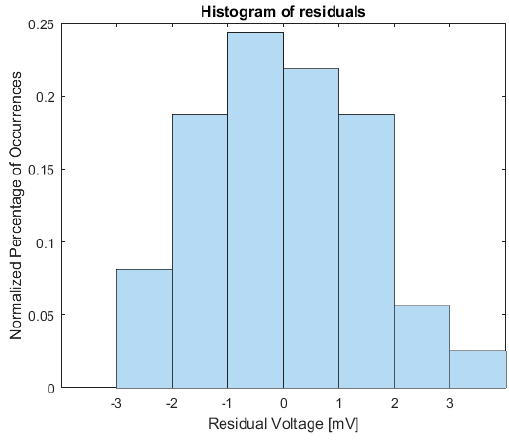
Figure 8. Residuals of linear regression model.